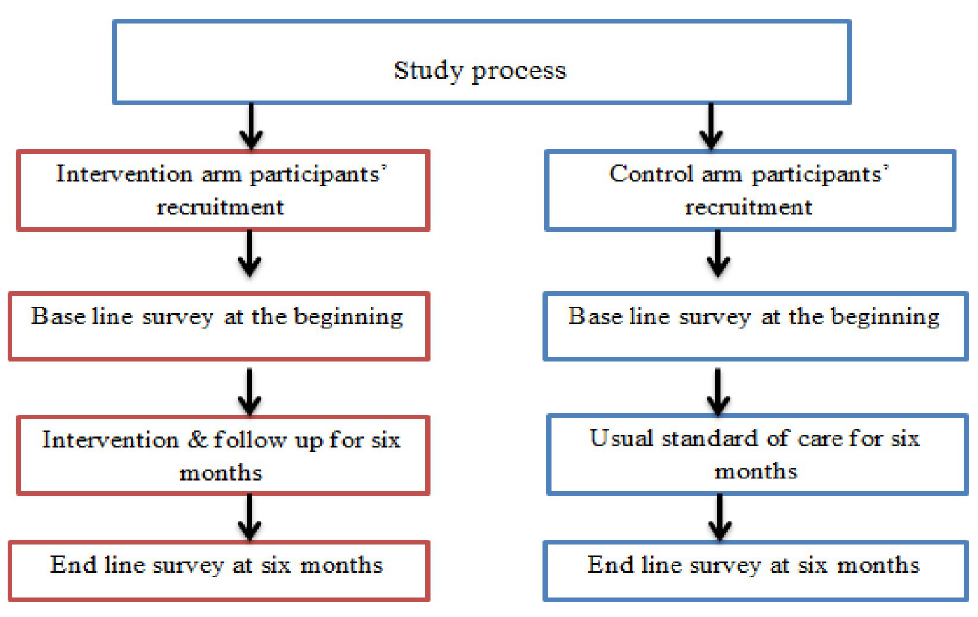
Fig 1. Implementation framework of the study